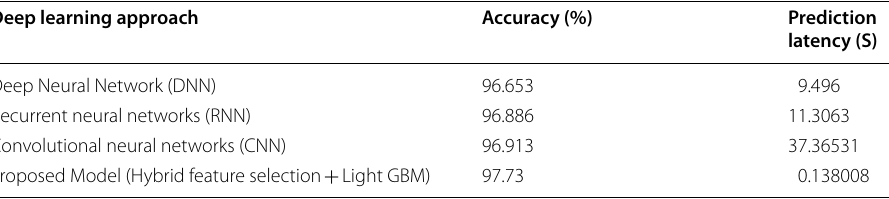
Table 14 Comparison of the proposed model with Ensemble Feature Selection Technique